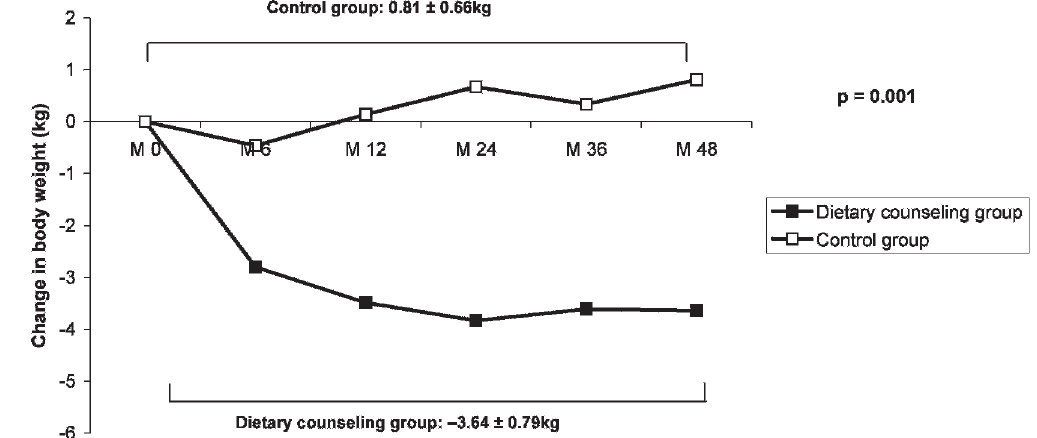
Figure 1 - Mean change in body weight during the study period according to dietary counseling. (M=month).